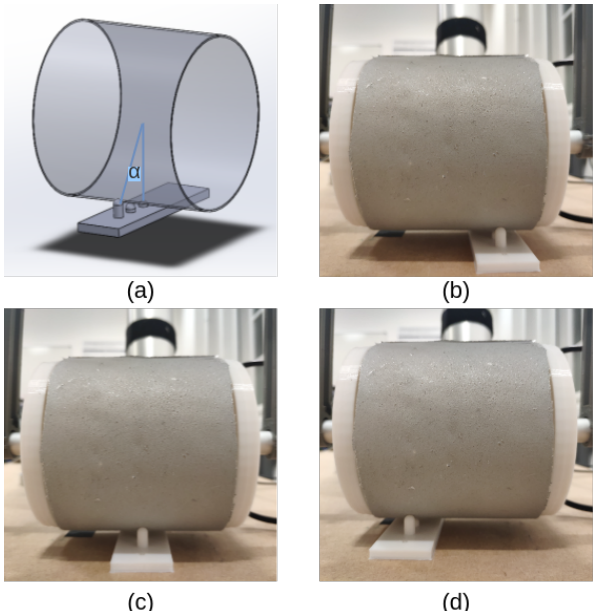
Figure 7. Contact localisation. ( a ) A 3D printed solid with three sticks of different heights is tapped vertically to the sensor ( α is the central angles according to the heights). ( b – d ) The solid is also tapped at different locations of the